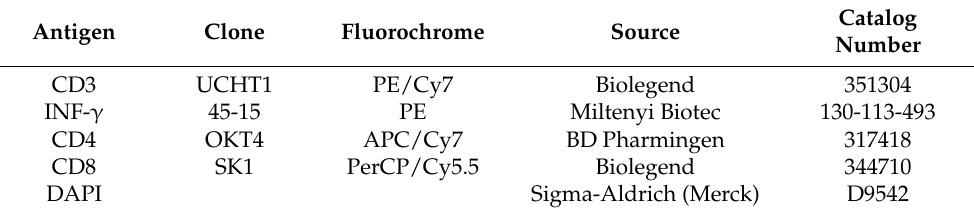
Table 1. List of fluorochrome-labeled antibodies used in flow cytometry studies. FITC, fluorescein isothiocyanate; PE, phycoerythrin; PE/Cy7, tandem comprising phycoerythrin and cyanine 7; APC, allophycocyanin; APC/Cy7, tandem comprising allophycocyanin and cyanine